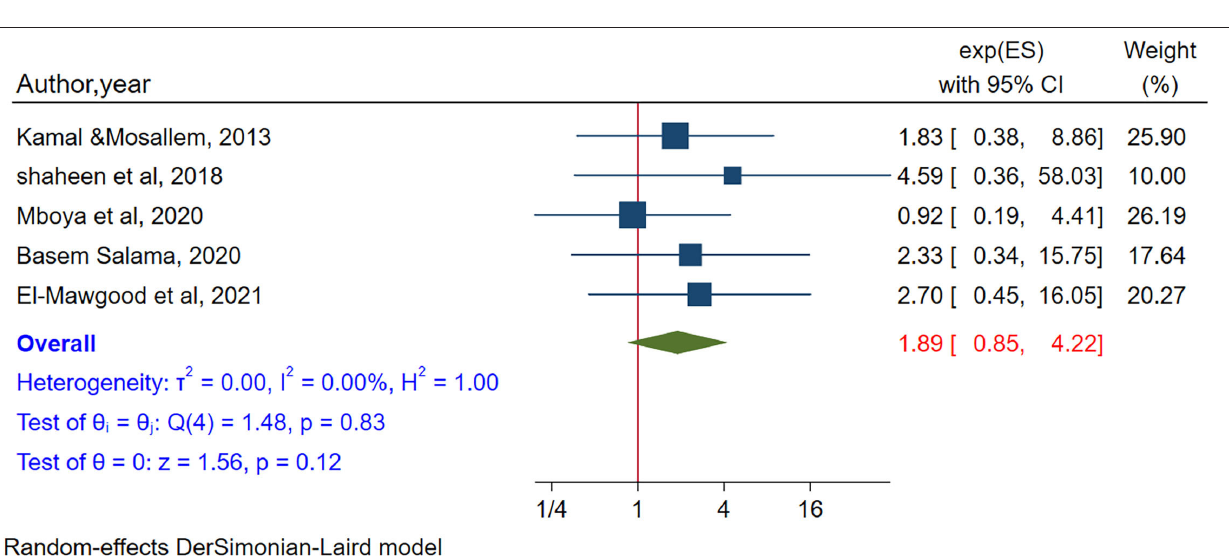
FIGURE 4 | The pooled association between residence and internet addiction.